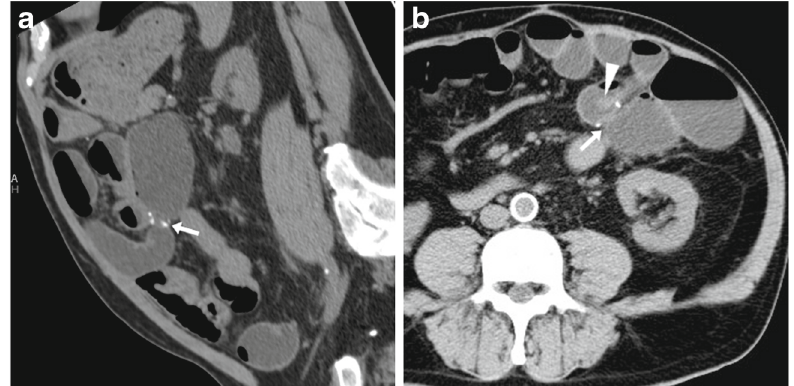
function, WE-MDCT showed moderately tight stapled anastomosis (arrows), with focal intraluminal vegetation (arrowhead) limited to the ileal side. Repeated endoscopy diagnosed anastomotic ulcer, stable at 6- month follow-up